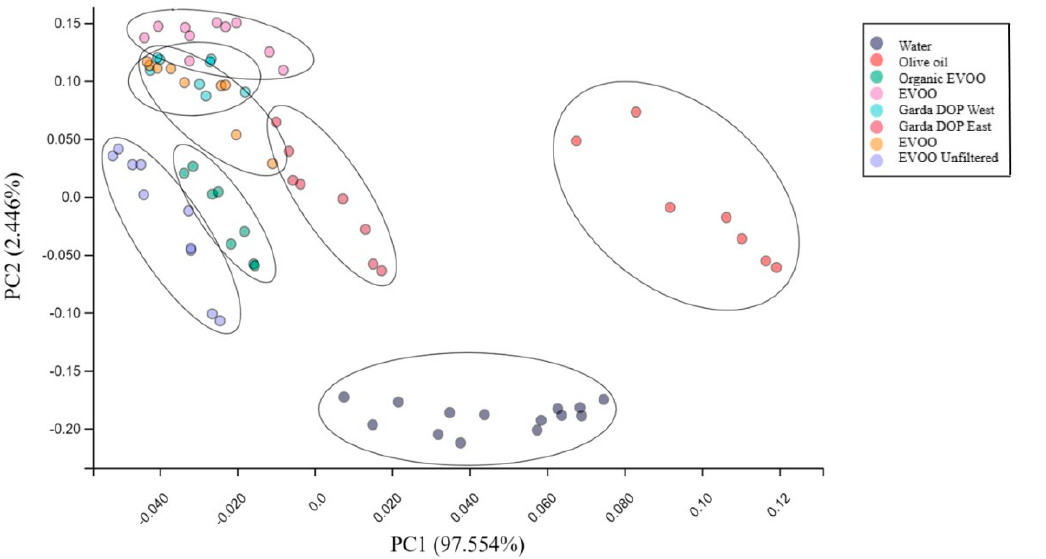
Figure 1. PCA score plot (PC1 vs . PC2) of eight metal oxides gas sensors response with respect to the target category olive oil samples and water (as control) represented by different clusters. Total explained variance: PC1 = 97.554%, PC2 = 2.446%.